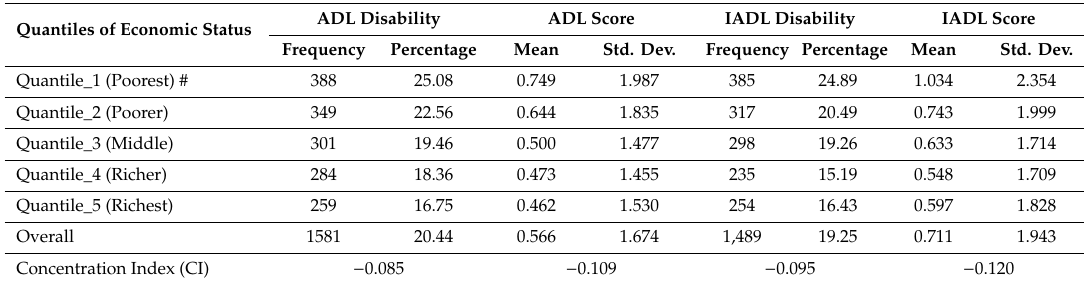
Table 2. Distribution and the concentration index of long-term care need across quantiles of economic